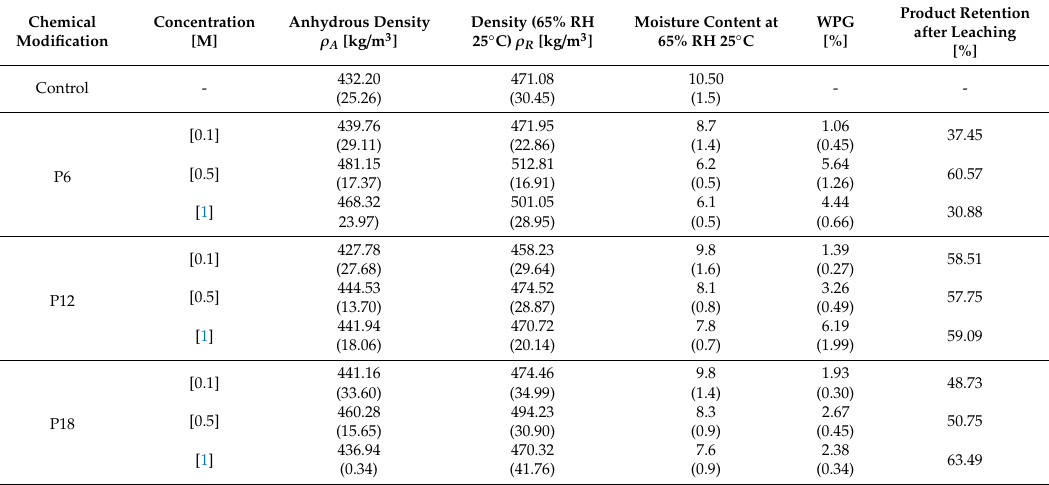
Table 3. E ff ects of esterification on density and